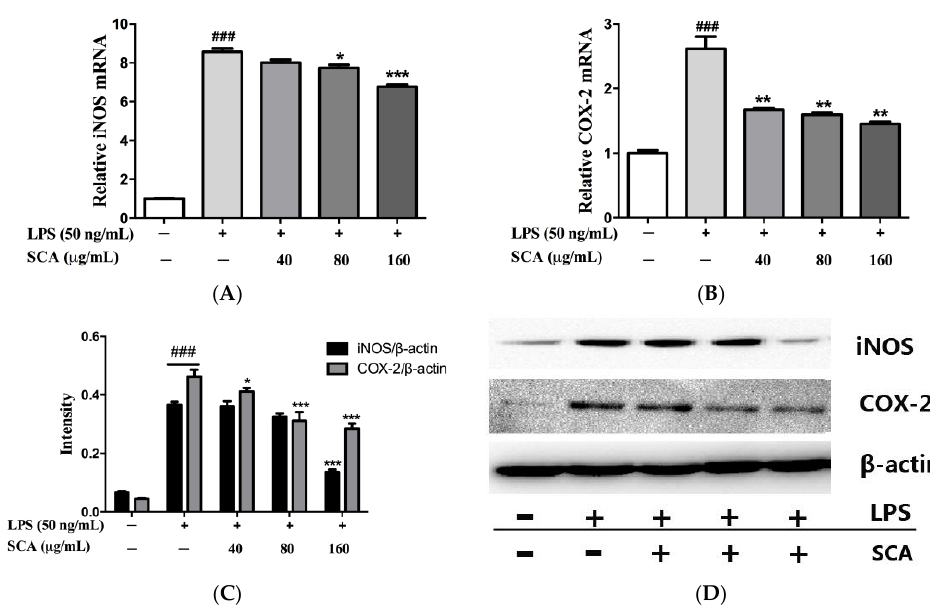
Figure 5. Effects of SCA on iNOS and COX-2 mRNA ( A and B ) and protein expressions ( C and D ). RAW 264.7 macrophages were treated with SCA (40, 80 and 160 μg/mL) for 1 h and then stimulated with LPS (50 ng/mL) for 24 h. The iNOS and COX-2 mRNA expressions were analyzed by RT-PCR. The iNOS and COX-2 proteins were analyzed by Western blotting. The bar chart shows the quantitative evaluation of iNOS and COX-2 protein bands by densitometry. * p < 0.05, ** p < 0.01 and *** p < 0.001 versus LPS-only treatment group; ### p < 0.001 versus control group.